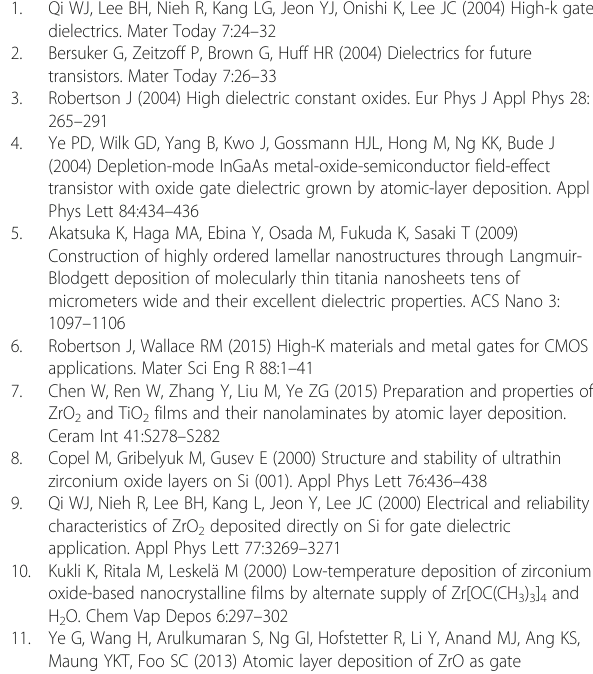
dielectric properties of ZrO film was studied utilizing 2 ZrO -based MIS device. The growth of the interface 2 layer between ZrO and Si substrate leads to the 2 decrease in the capacitance and the leakage current of dielectric layer in the MIS device after 1000 °C anneal- ing. ZrO film exhibits the relatively high dielectric 2 constant of 32.57 at 100 kHz and the low leakage current density of 3.3 × 10 − 6 A cm − 2 at 1 MV/cm.